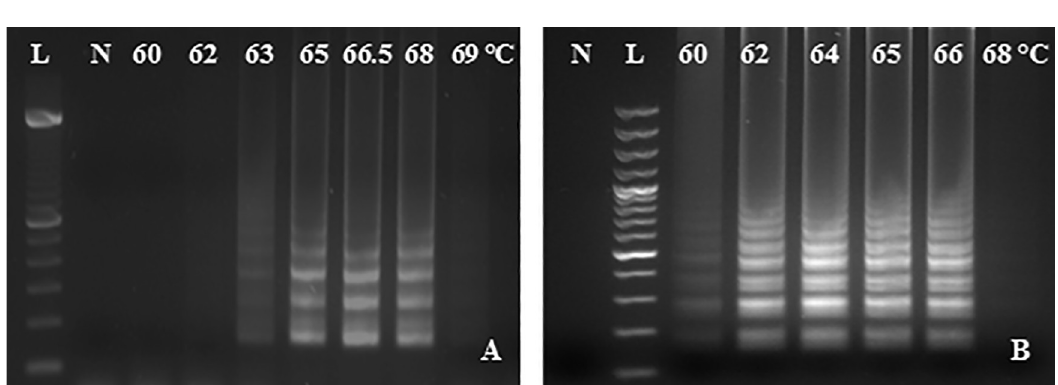
Fig 3. RT-LAMP temperature gradient assay from 60 to 69˚C using Bst 2.0 DNA polymerase. A) RRV-P3 primers and RRV-P3 plasmid as template B) RRV-P4 primers and RRV-P4 plasmid as template. Lane L is a 100 bp DNA ladder and lane N, is a non- template control (NTC, water).